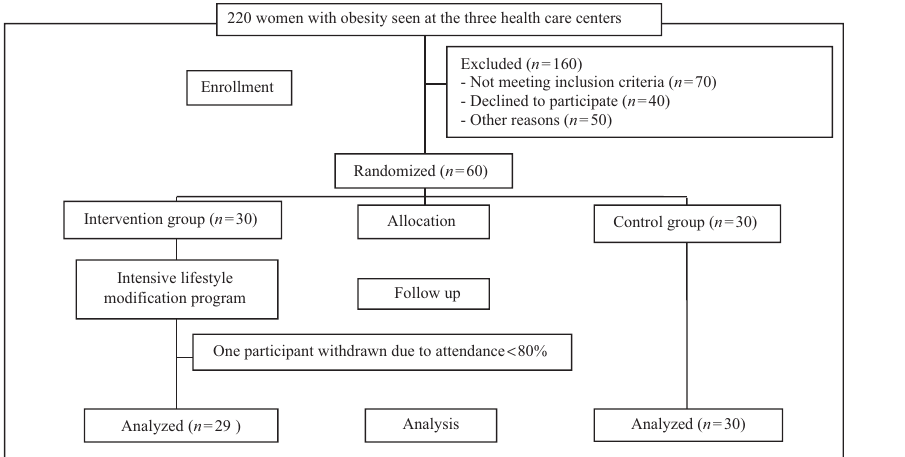
Figure 1. Flow chart